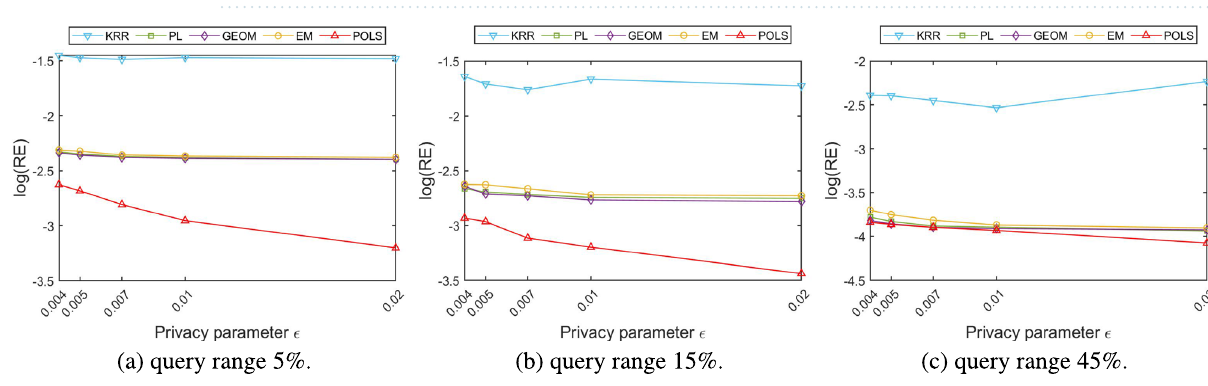
Figure 11. Comparison of range counting query accuracy (dataset with 50,000 users).